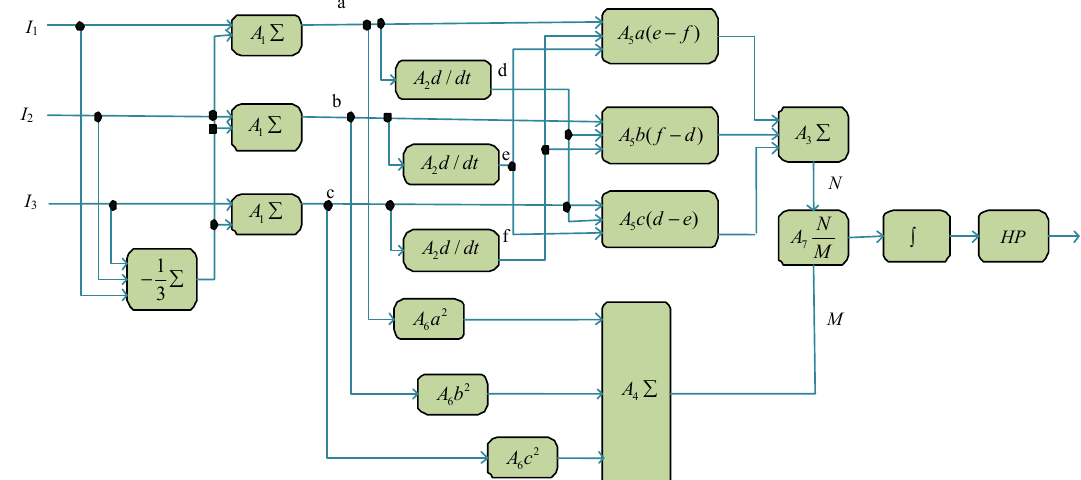
Fig . 4 Interferometer phase demodulation mathematical model based on the 3 × 3 fiber coupler.